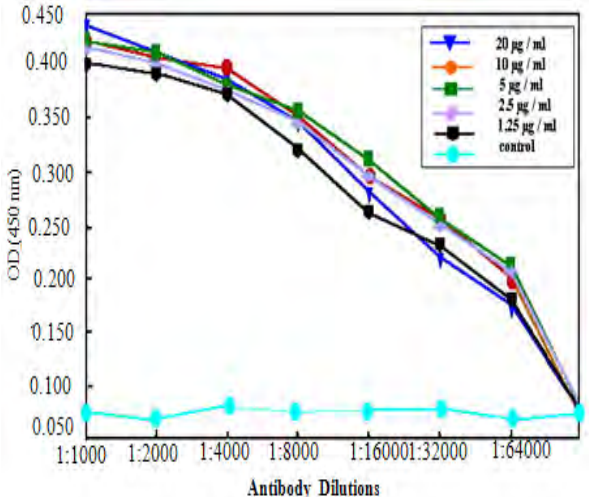
Figure 2: Two-dimentional titration of various dilutions of serum against AcAaIT polyhedrin with different concentrations (0.0, 1.25, 2.5, 5, 10 and 20 µg/ml) of AcAaIT polyhedrin as the coating